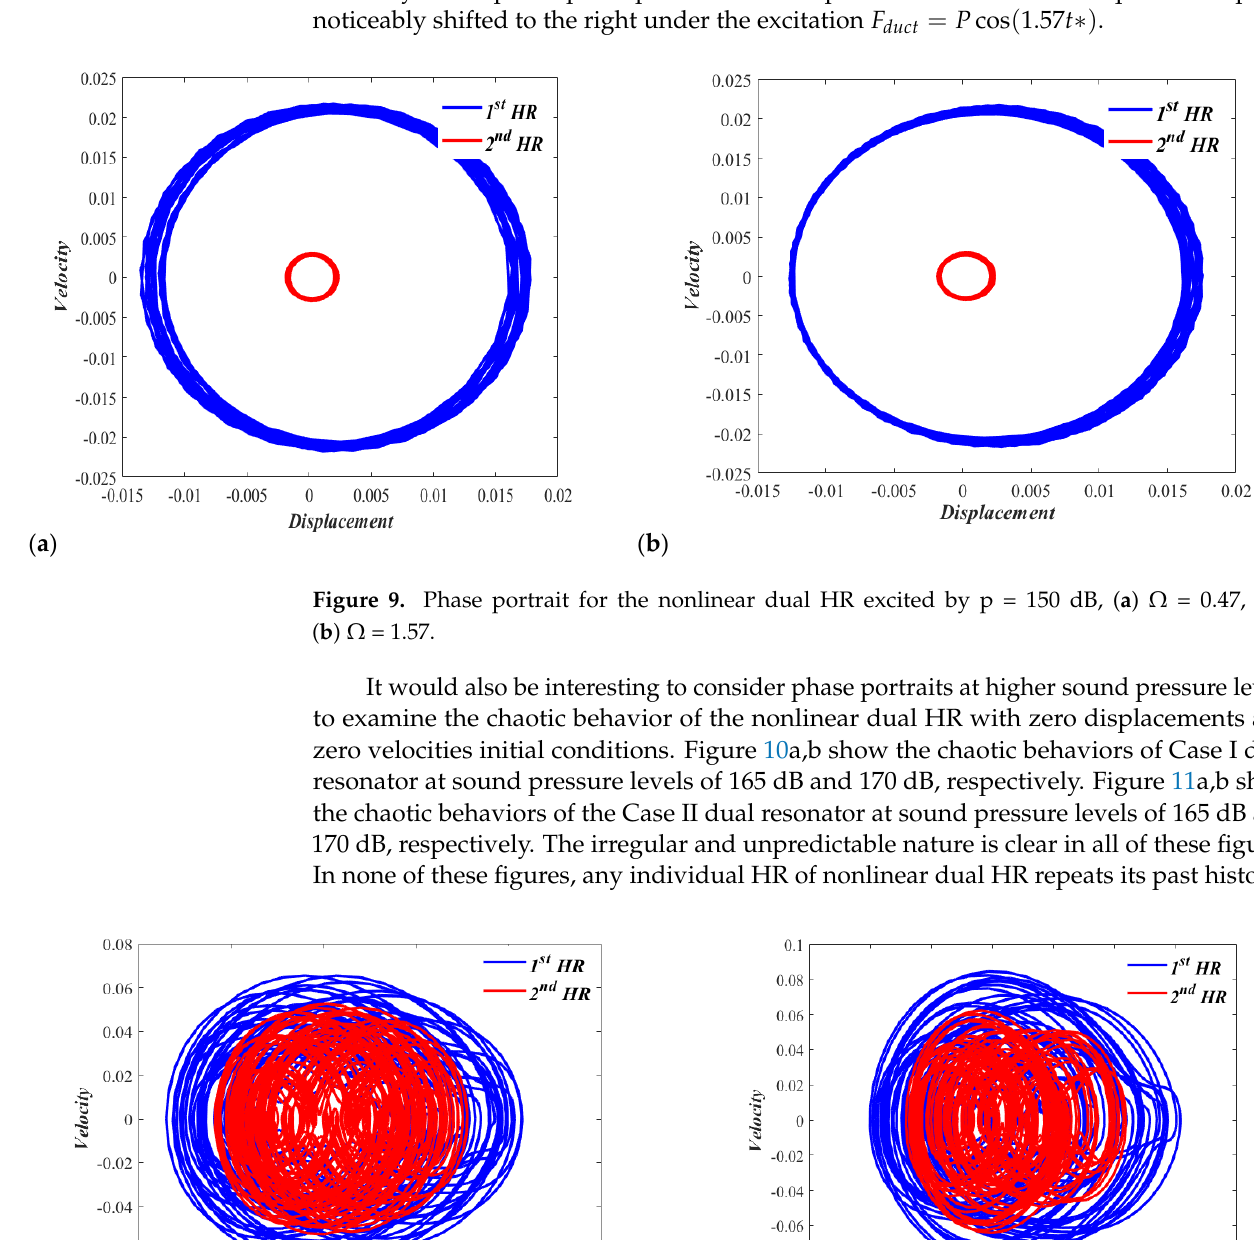
Figure 8. Phase portrait for the nonlinear dual HR excited by p = 150 dB, ( a ) Ω = 0.65, and ( b ) Ω =